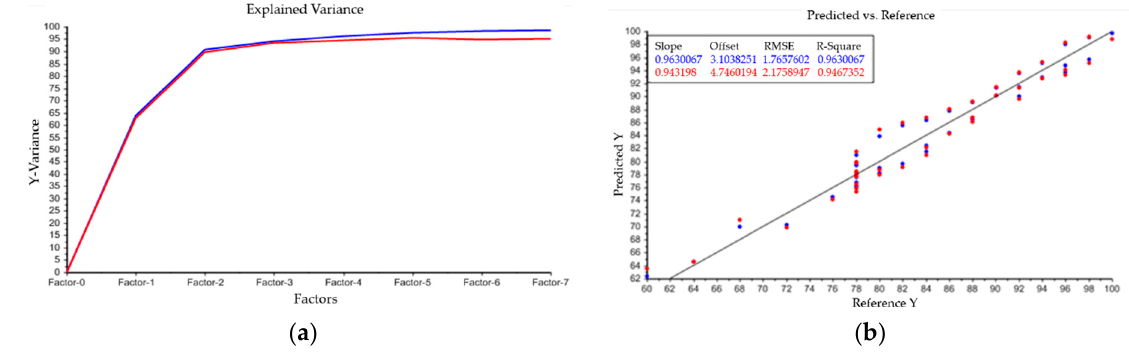
Table A3. Results of the conducted DoE and evaluation of effects on product yield and purity.